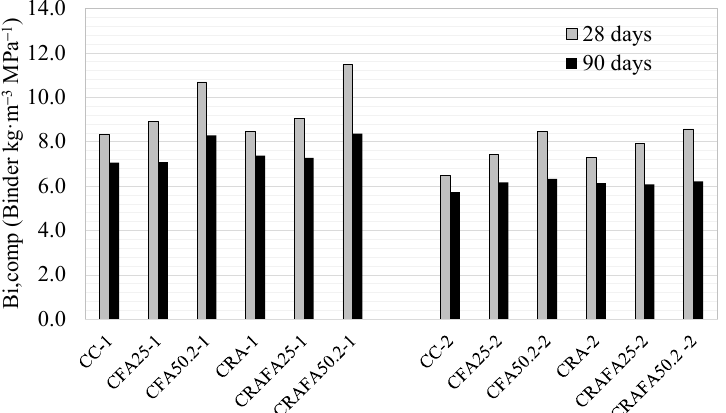
Figure 10. The binder intensity (Bi-comp) for Series 1 and Series 2 concretes at 28 days and 90 days of curing.